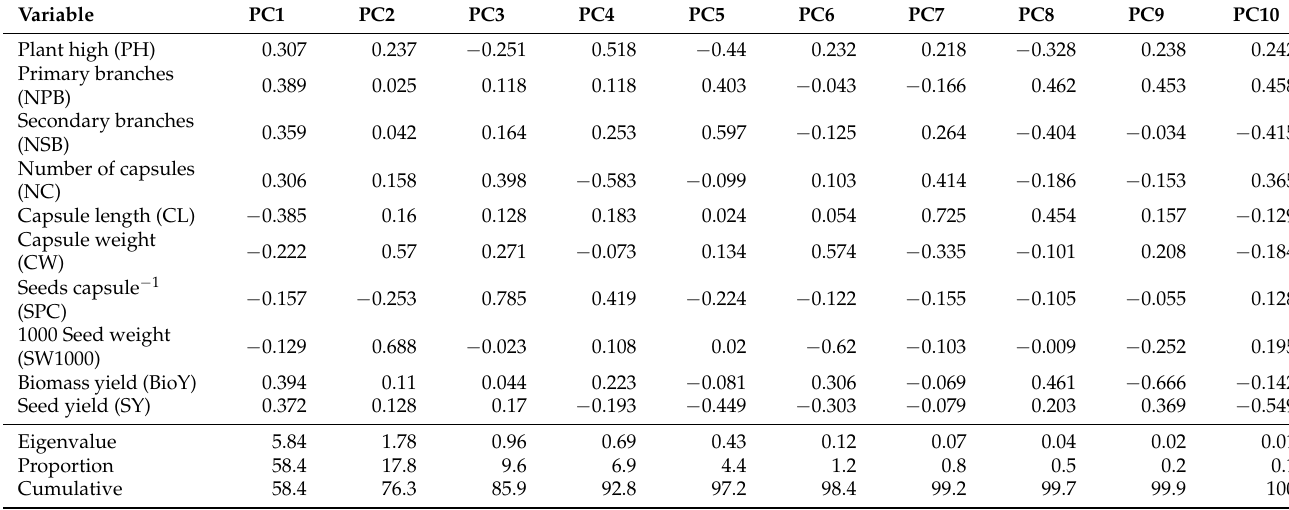
Figure 11. PCA biplot of the agronomic traits of sesame and treatment interactions (cultivar × location × year). Table 4. Principal component matrix of the agronomic traits of sesame and treatment interactions (cultivar × location × year).